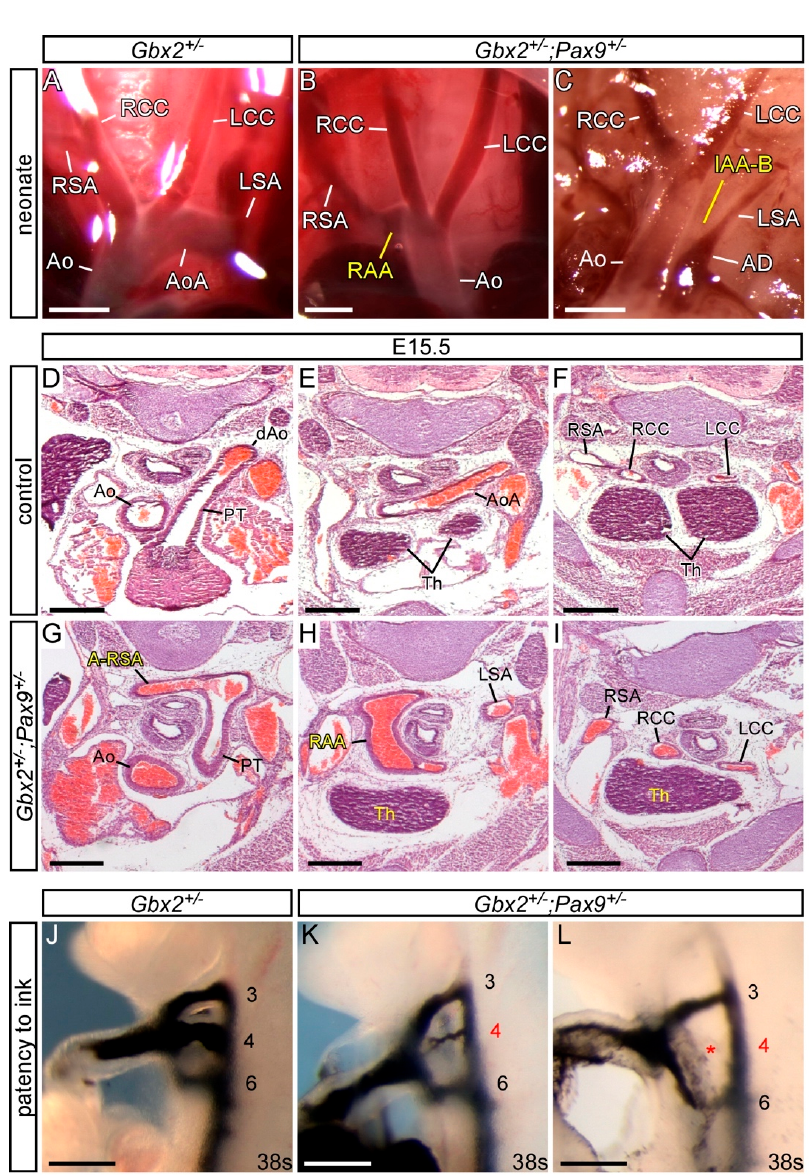
Figure 3. Cardiovascular defects in Gbx2 +/ − ;Pax9 +/ − mice. ( A – C ) Neonates were dissected on the day of birth. ( A ) Arch arteries of control neonates were normal. ( B ) A subset of Gbx2 +/ − ;Pax9 +/ − neonates (4 / 12) displayed right-sided aortic arch (RAA; B ) or IAA-B ( C ). ( D – I ) H&E stained transverse sections of E15.5 embryos. ( D – F ) Normal outflow tract ( D ), aortic arch arteries and thymus (Th; E , F ) in a control embryo. ( G – I ) A Gbx2 +/ − ;Pax9 +/ − embryo (from n = 16) with aberrant right subclavian artery (A-RSA; G ), a right-sided aortic arch (RAA; H ) and abnormal thymus ( H , I ). ( J – L ) Intracardiac ink injection into E10.5 embryos (34–41 somites). ( J ) In control embryos, PAAs 3–6 are patent to ink, are of equivalent diameter and are bilaterally symmetrical. ( K , L ) In Gbx2 +/ − ;Pax9 +/ − embryos (n = 63), 32% had hypoplastic ( K ) or non-patent to ink ( L ; asterisk) 4th PAAs. Scale bars: 1 mm in ( A – C ); 500 µ m in ( D – L ). Abbreviations: AD, arterial duct; Ao, aorta; AoA, aortic arch; LCC, left common carotid artery; LSA, left subclavian artery; PT, pulmonary trunk; RCC, right common carotid artery; RSA, right subclavian artery; s, somites. The somite numbers given in the legend reflect the range analysed for the whole study. The figure contains representative images